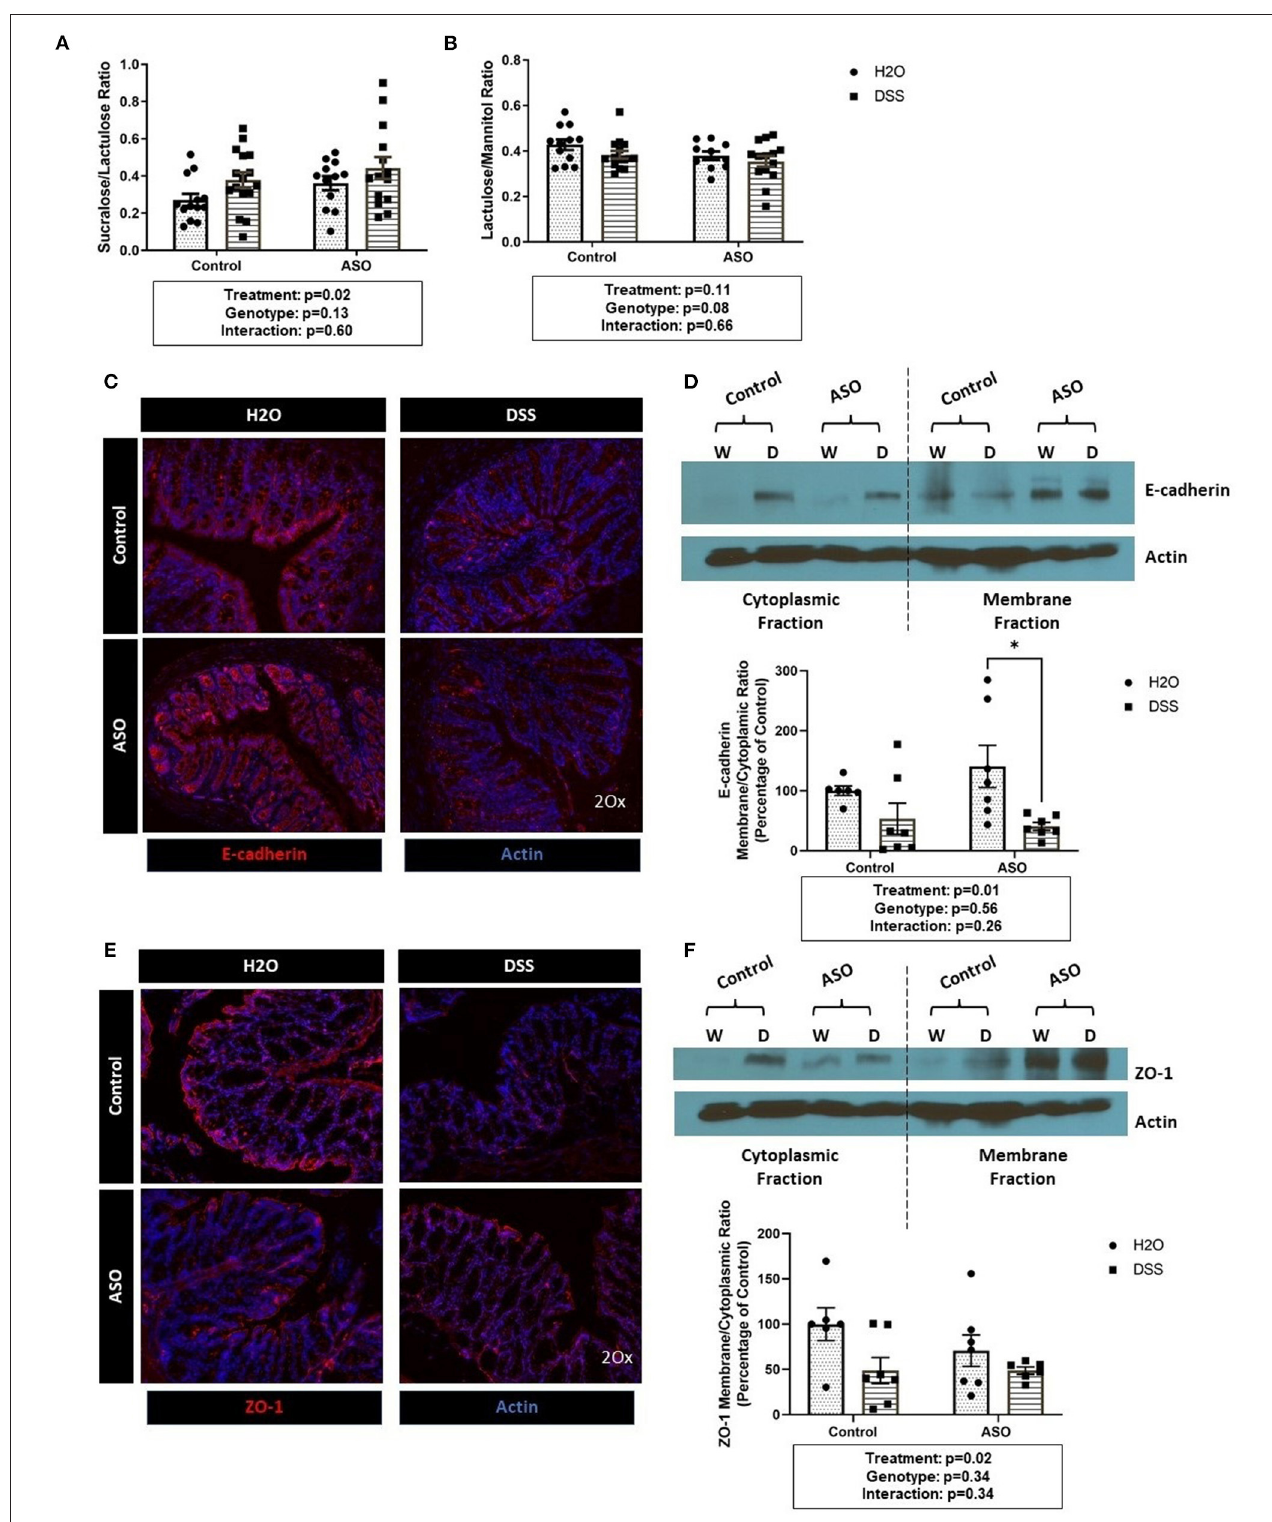
FIGURE 2 | Impact of DSS on the intestinal barrier. (A) Mice treated with DSS exhibited intestinal barrier dysfunction, specifically in the colon, as assessed the by the sucralose/lactulose ratio. (B) Small intestinal permeability was similar in all groups regardless of genotype and treatment, based on the lactulose/mannitol ratio. (C) Immunofluorescent staining of E-cadherin (red) in colonic tissue (DAPI, blue) showing reduced staining in DSS treated tissue. (D) The membrane/cytoplasm ratio of